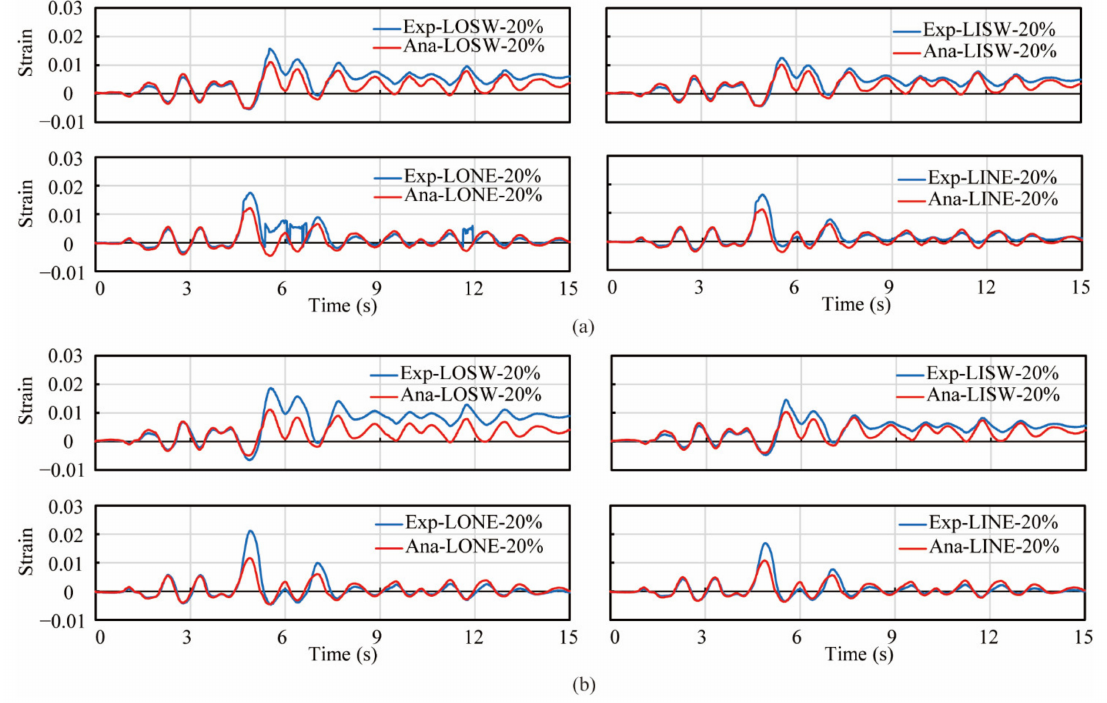
Figure 11. Correlation of strain in longitudinal reinforcements during the 2nd excitation. ( a ) PFRC-1, ( b )